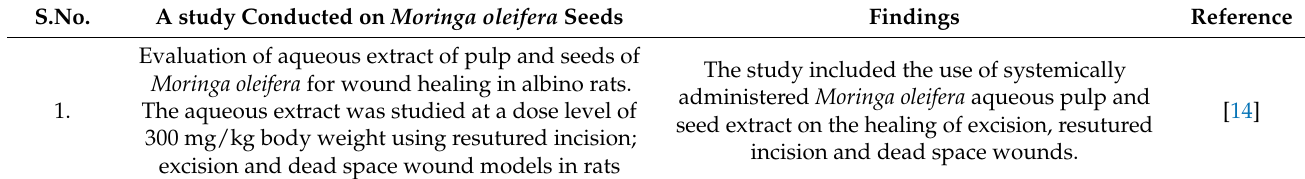
Table 1. Studies on wound healing efficacy of Moringa oleifera